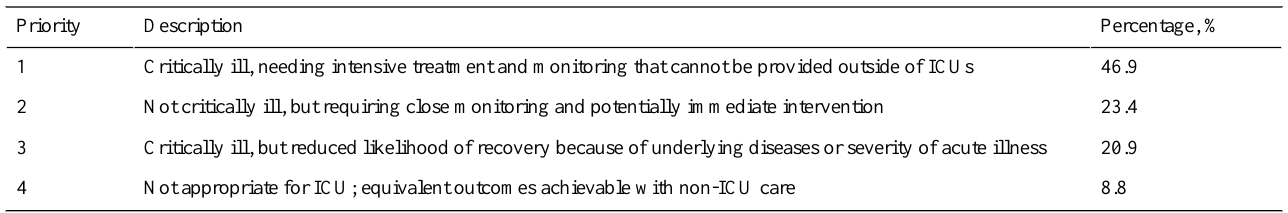
Table 1. Priority levels of medical intensive care unit (ICU) admissions at Harbor-University of California Los Angeles Medical Center.